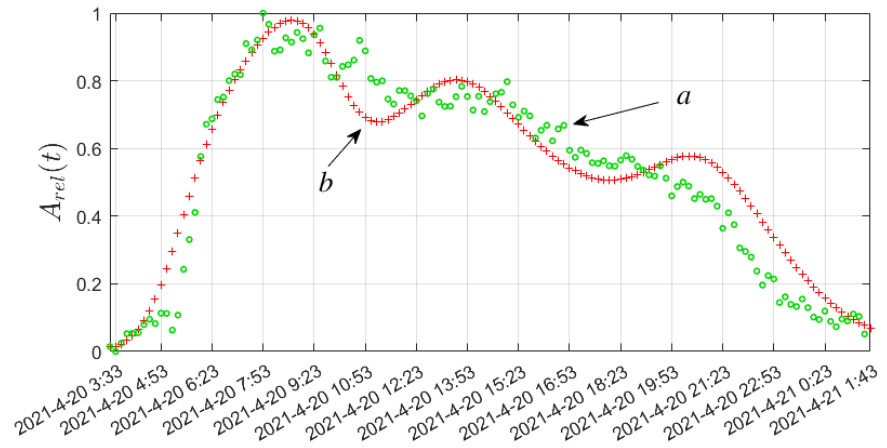
Figure 12. (a) RVA burst data from MRZR in 10 min increments; (b) simulation results for (12) with determination coefficient ( R 2 = 0.91) and Pearson correlation coefficient ( Corr = 0.96).